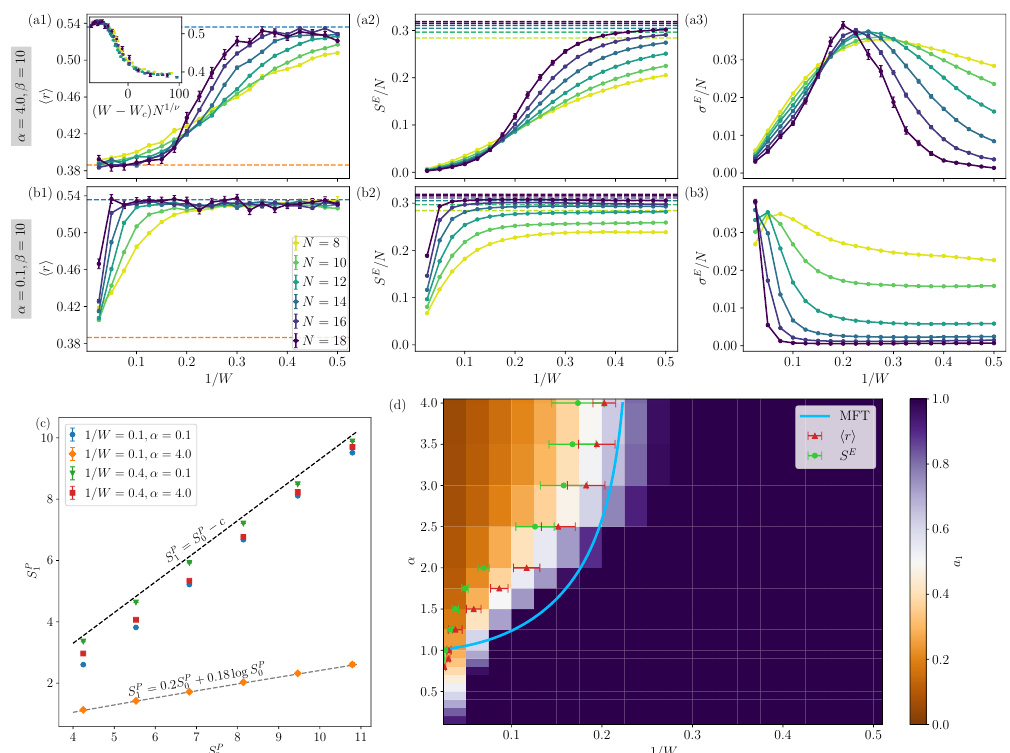
Figure 3: Numerical phase diagram in a constant- β plane: Top two rows show data for the mean level-spacing ratios 〈 r 〉 , the mean entanglement entropy S E , and the fluctuations in the entanglement entropy σ E , as a function of the inverse disorder strength, 1 / W , for a fixed value of β = 10 and two values of α = 4 (top panels (a1)- (a3)) and α = 0.1 (middle panels (b1)-(b3)). Data are shown for N = 8 − 18 spins. For α = 0.1, 〈 r 〉 stays pinned to the GOE value even for large W and there is no visible crossing of the data for various N , indicating the absence of the MBL phase. For α = 4 on the other hand, there is a clear crossing of the data at finite W suggesting a tran- sition, with 〈 r 〉 going to the GOE and Poisson values (blue and orange dashed lines respectively) at weak and strong disorder; the inset to panel (a1) gives the scaling [( W − W ) N 1 /ν ] , which shows good scaling collapse. The half-chain en- function g r c tanglement entropy S E / N also shows the same behaviour: for α = 0.1 it remains very close to the Page corrected volume-law value S E / N = log2 − 1 / ( 2 N ) [ 48 ] (dashed lines) even for large W , whereas for α = 4 there is a clear crossing of the data sug- gesting a transition. Fluctuations in entanglement entropy are likewise consistent, showing for α = 0.1 that with increasing N its peak shifts to progressively higher values of W , suggesting a delocalised phase throughout in the thermodynamic limit; whereas the peak for α = 4 lies quite close to the critical W predicted by the 〈 r 〉 c and S E data. Panel (c) shows the scaling of the first participation entropy S P with 1 = log N the logarithm of the Fock-space dimension, S P , for two representative val- H 0 (cid:39) 1, ues of W and two values of α . While for α = 0.1 both values of W show a 1 for α = 4, a changes from (cid:39) 1 at W = 0.25 to (cid:39) 0.2 at W = 10, indicating the 1 occurrence of a transition. The a values in the ( α ,1 / W ) -plane are shown a colour- 1 map in panel (d), clearly showing W moves to higher values as α is decreased. The c W values extracted from finite-size scaling analyses of 〈 r 〉 and S E are also shown, c and are concomitant with the phase boundary predicted from participation entropies. These phase boundaries are remarkably consistent overall with the prediction from the mean-field theory, which is shown by the light blue line in panel